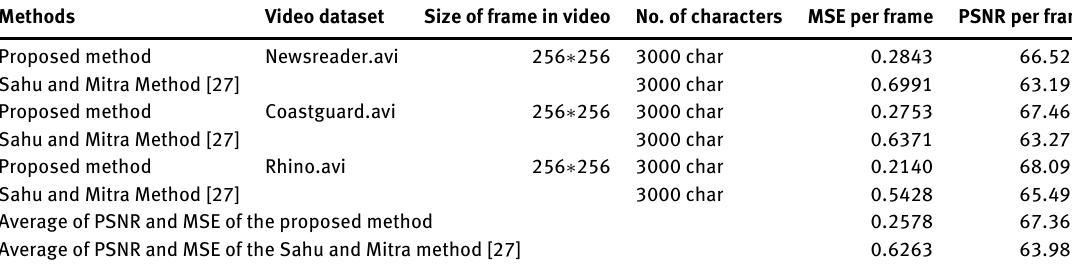
Table 2: The Experimental Results of the Proposed